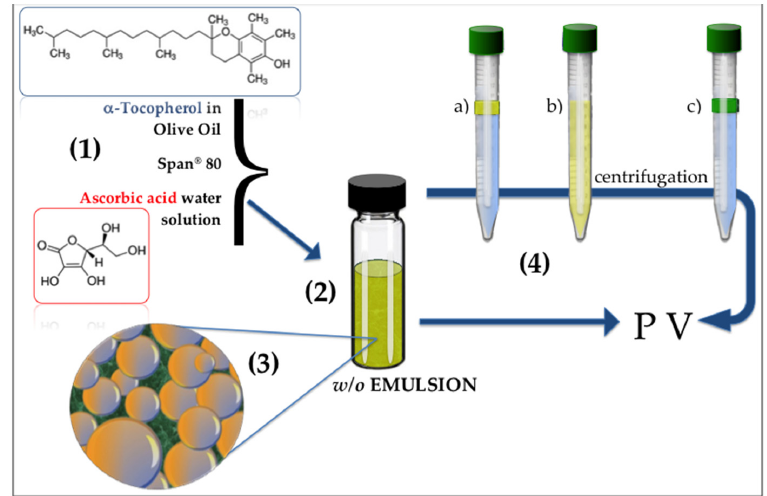
Scheme 1. Schematic representation of emulsion preparation for the peroxide values (PV)